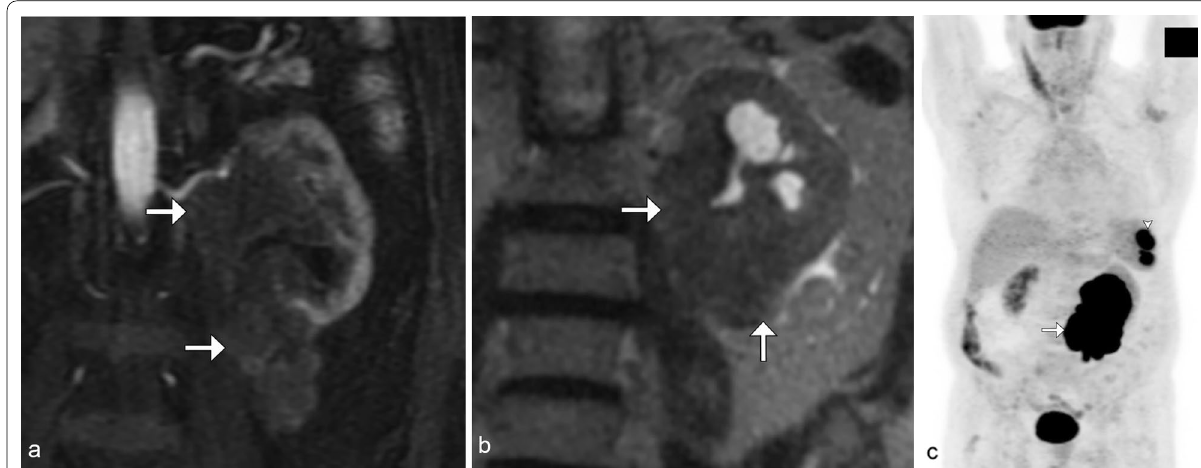
Fig. 9 Renal sinus involvement of renal lymphoma. Coronal MRI post contrast ( a ) and T2 weighted ( b ) images demonstrate a T2 hypointense, hypoenhancing infiltrative left renal mass (arrows) invading the upper pole collecting system and lower kidney. Note the resultant mild hydronephrosis relative to tumor size. PET/CT ( c ) shows the marked F18-FDG avid left renal mass (arrow) as well as splenic masses (arrowhead). This was biopsy-proven high-grade B-cell